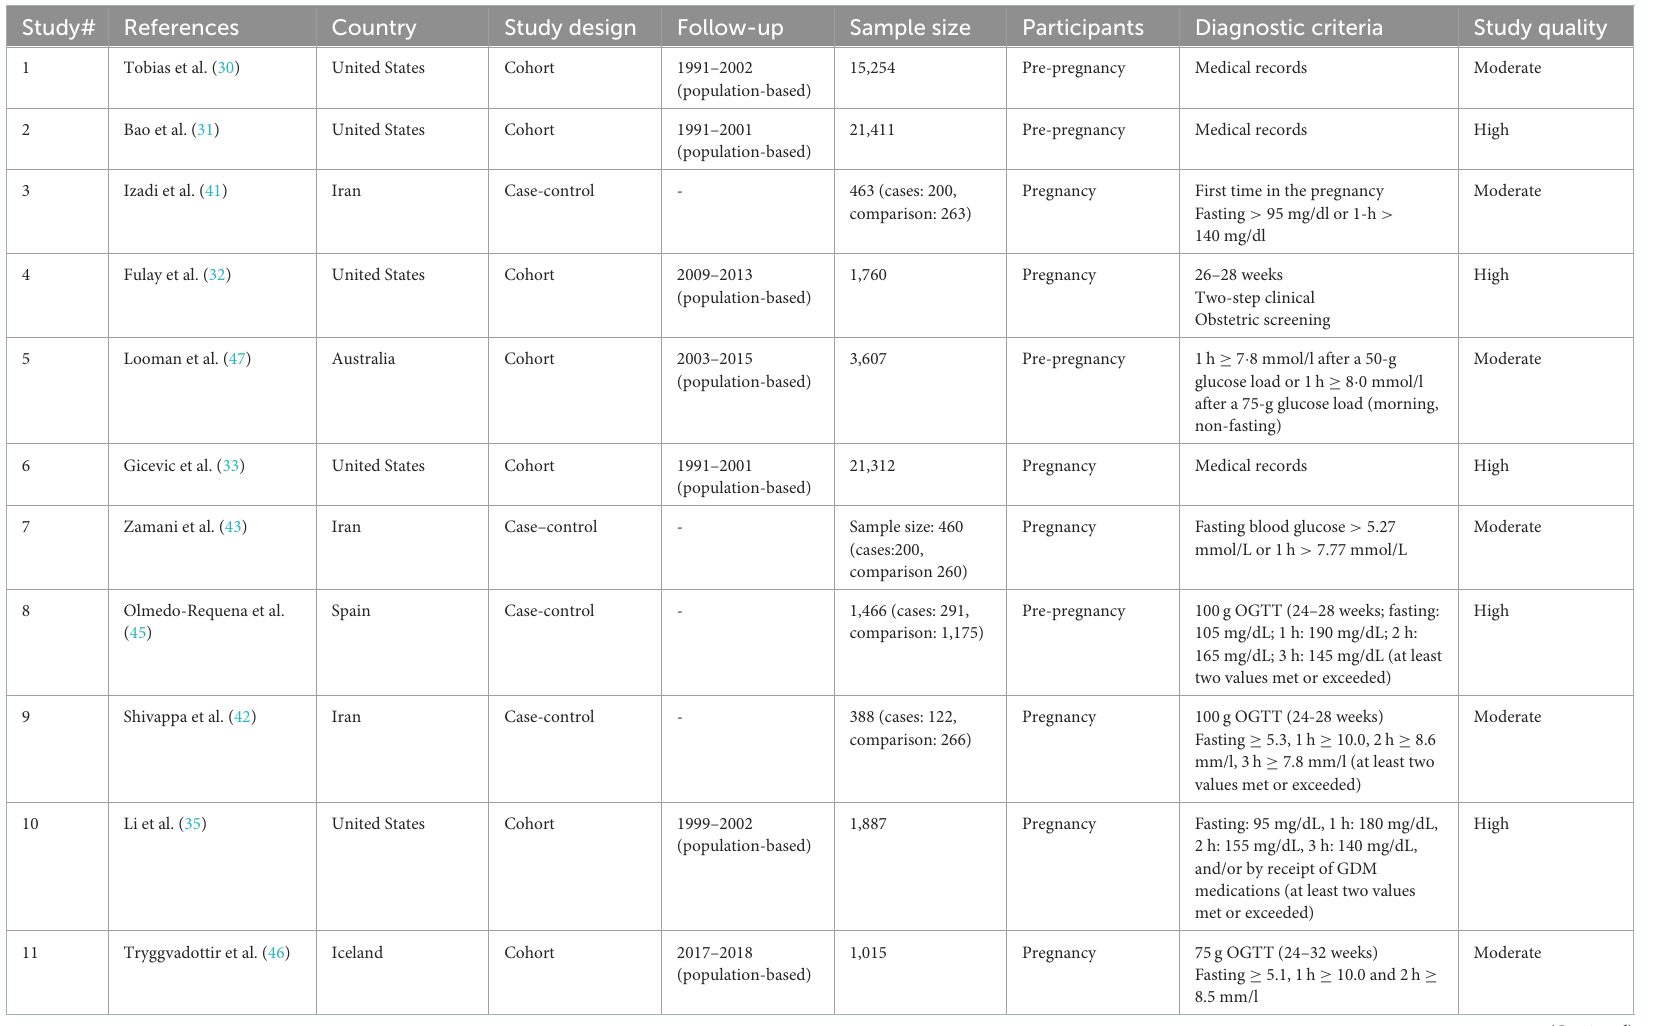
TABLE 1 Eligible study